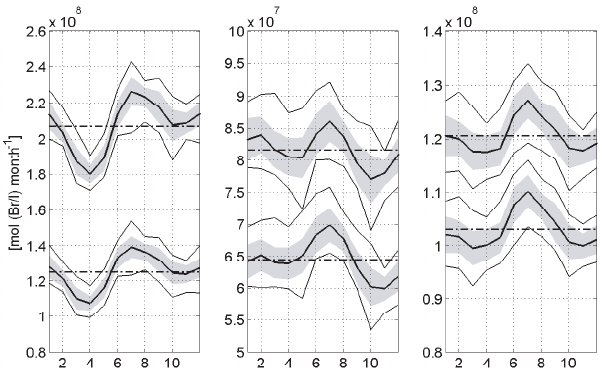
Fig. 8. Global monthly sea-to-air flux averages of bromoform (left), dibromomethane (centre) and methyl iodide (right) in mol (Br/I) month − 1 (bold solid line) from 1989 to 2011, including their stan- dard deviation (grey shaded area) and their minimum and maximum value (solid line). Additionally, the respective annual mean value is marked (dash-dotted line). The upper graphs show the oceanic emis- sions using the OLS regression technique and the bottom graphs the RF calculated